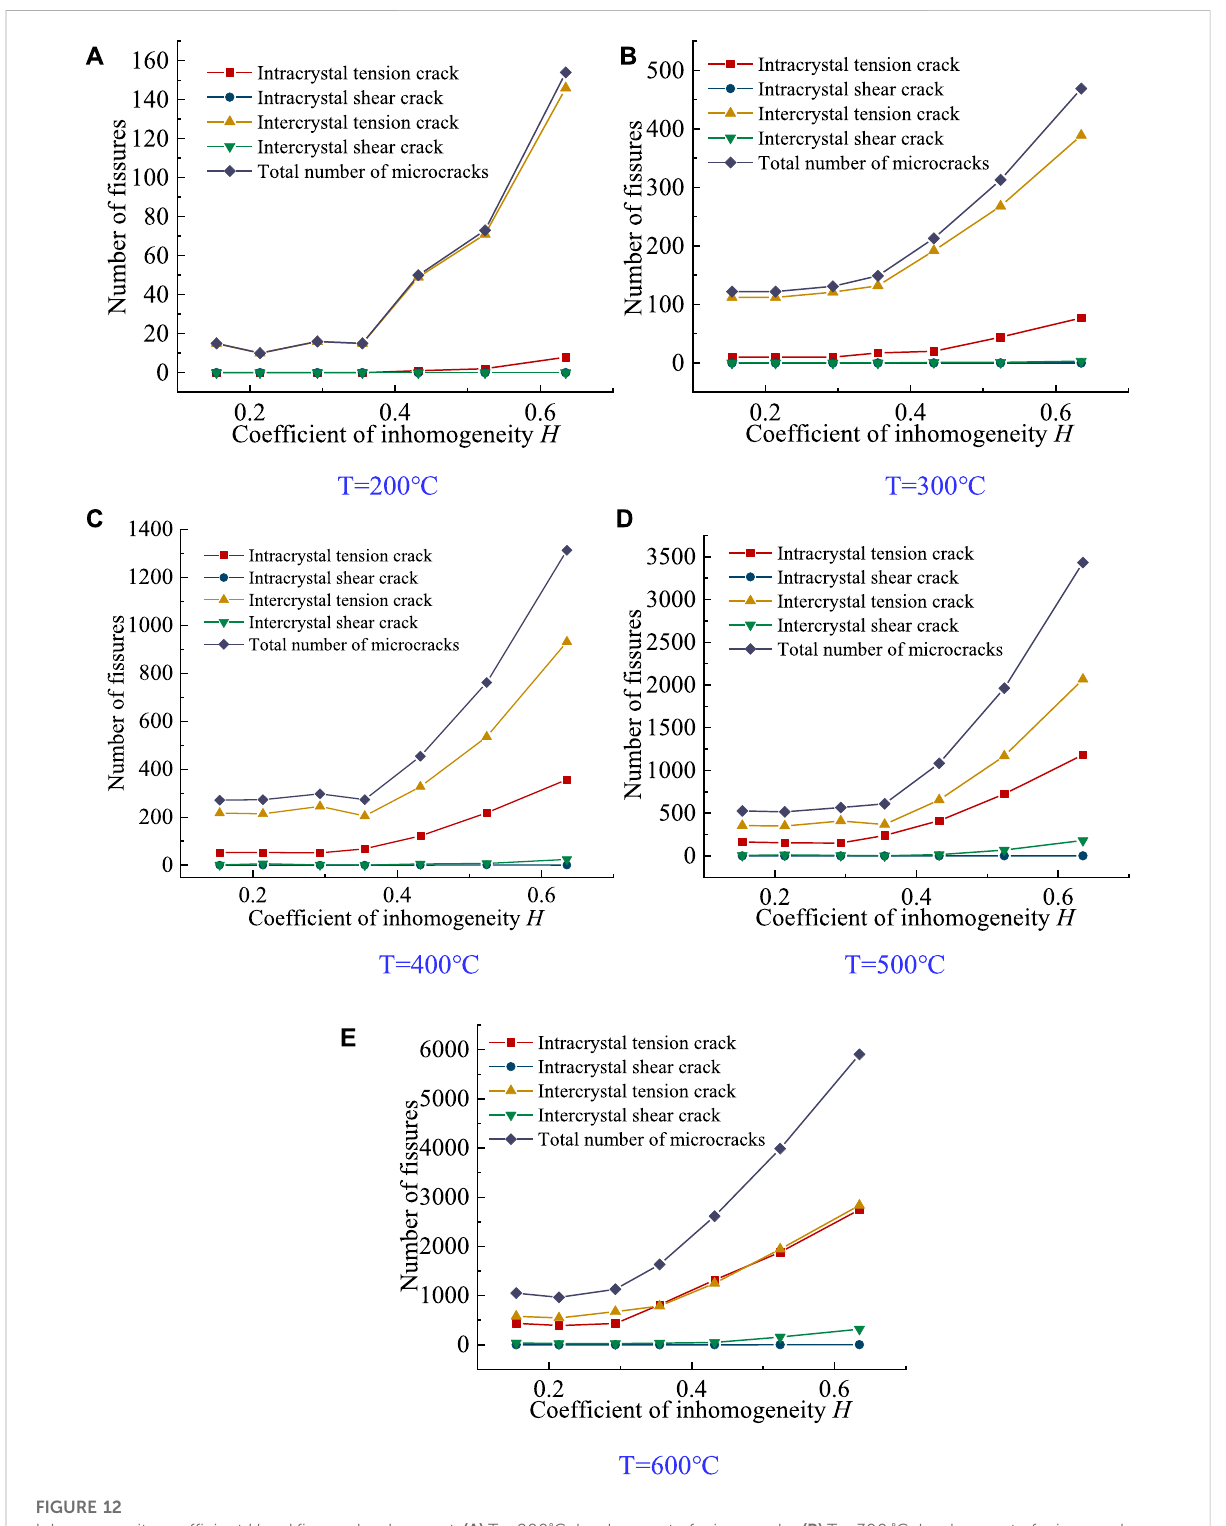
FIGURE 12 Inhomogeneitycoef fi cient H and fi ssuredevelopment. (A) T=200 ° Cdevelopmentofmicrocracks. (B) T=300 ° Cdevelopment ofmicrocracks. (C) T = 400 ° C development of microcracks. (D) T = 500 ° C development of microcracks. (E) T = 600 ° C development of